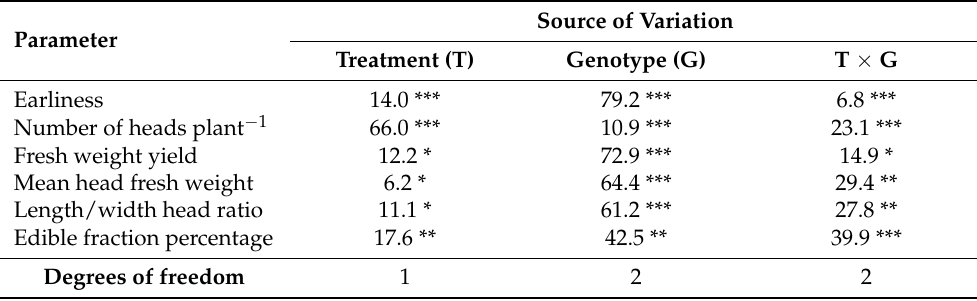
Table 6. Mean square per each source of variation (percentage of total) resulting from the analysis of variance on the parameters relating to earliness, yield response, and head bio-morphological characterization of the globe artichoke. ***, **, * indicate significance at p < 0.001, p < 0.01 and p < 0.05.